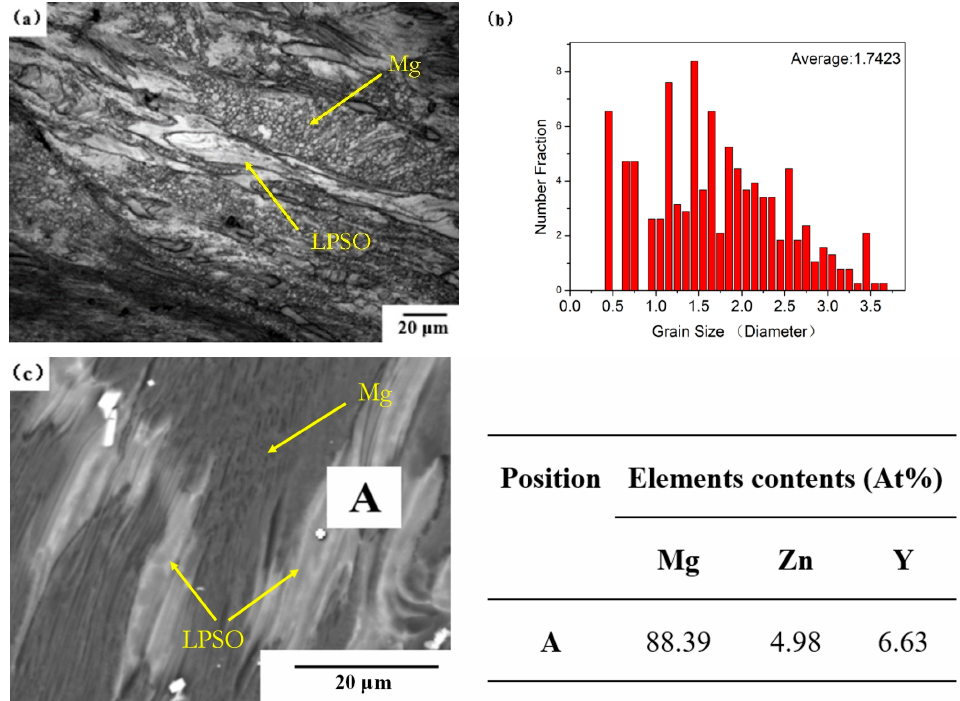
Figure 1. Microstructure of an as-extruded Mg–2.5Zn–4Y alloy containing LPSO phases: ( a ) OM image; ( b ) average grain size map; ( c ) SEM image and EDS point analysis results.